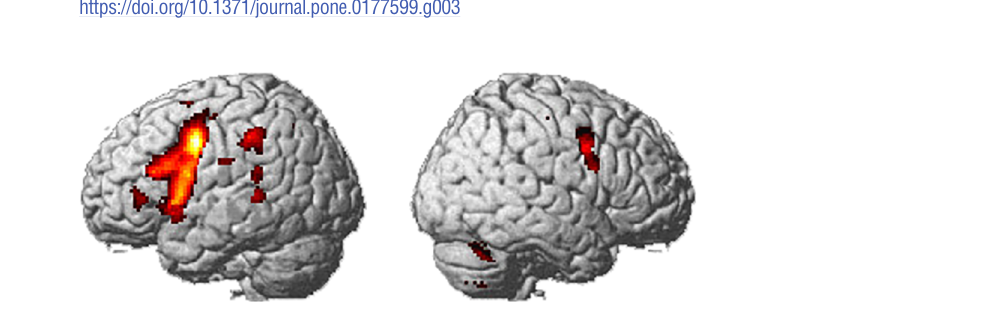
Fig 4. Global activation during the maintenance stage. Conjunction analysisof the letter and fingerspellingconditionsrevealedthe left-hemisphere network includingthe perisylvianlanguage area.